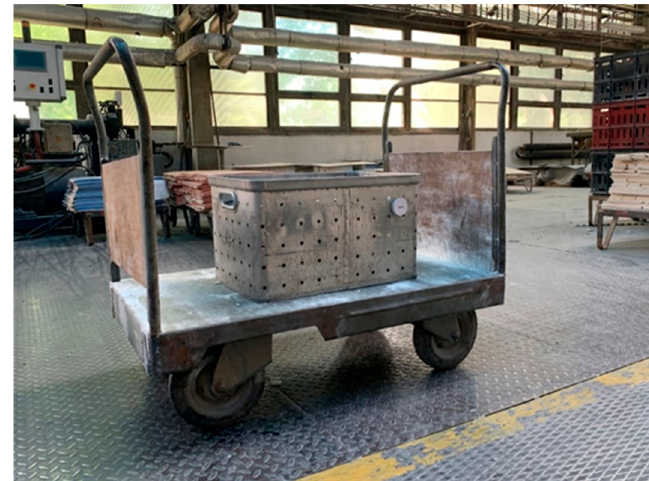
Figure 6. Crate equipped with iBKS 105 beacon.